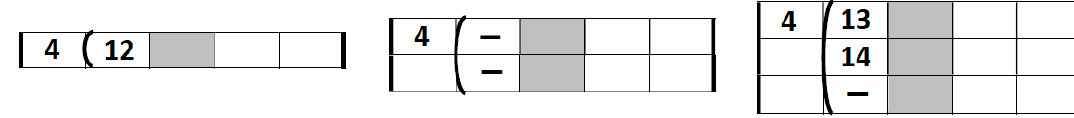
Figure A3. Notation of free throws.